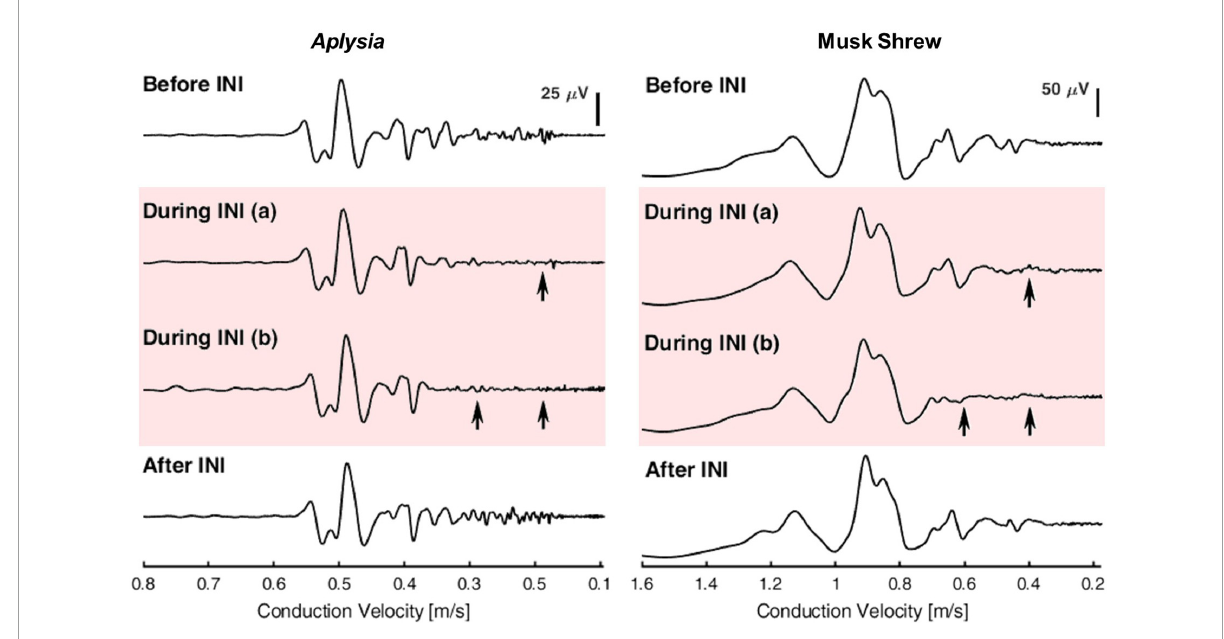
FIGURE4 Demonstration of selective inhibition on small-diameter axons in Aplysia (left) and musk shrew (right) . Compound action potentials (CAPs) were evoked and recorded before, during, and after infrared neural inhibition (INI). Arrows indicate the selective inhibition effect on small-diameter axons that have a slower conduction velocity. The CAPs before and after INI remained similar, suggesting that the selective inhibition effect was reversible and the nerve’s health was not compromised acutely. Reproduced with permission from Lothet et al. (2017). The original work is published under a Creative Commons Attribution 4.0 International License. To view a copy of this license, visit